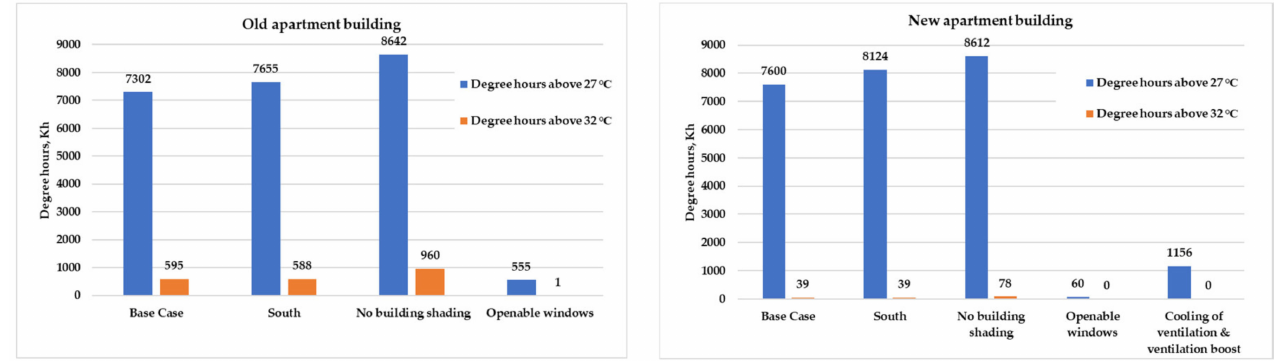
Figure 8. The annual degree hours above 27 ◦ C and 32 ◦ C in different cases of the old and new building with TRY2050 future